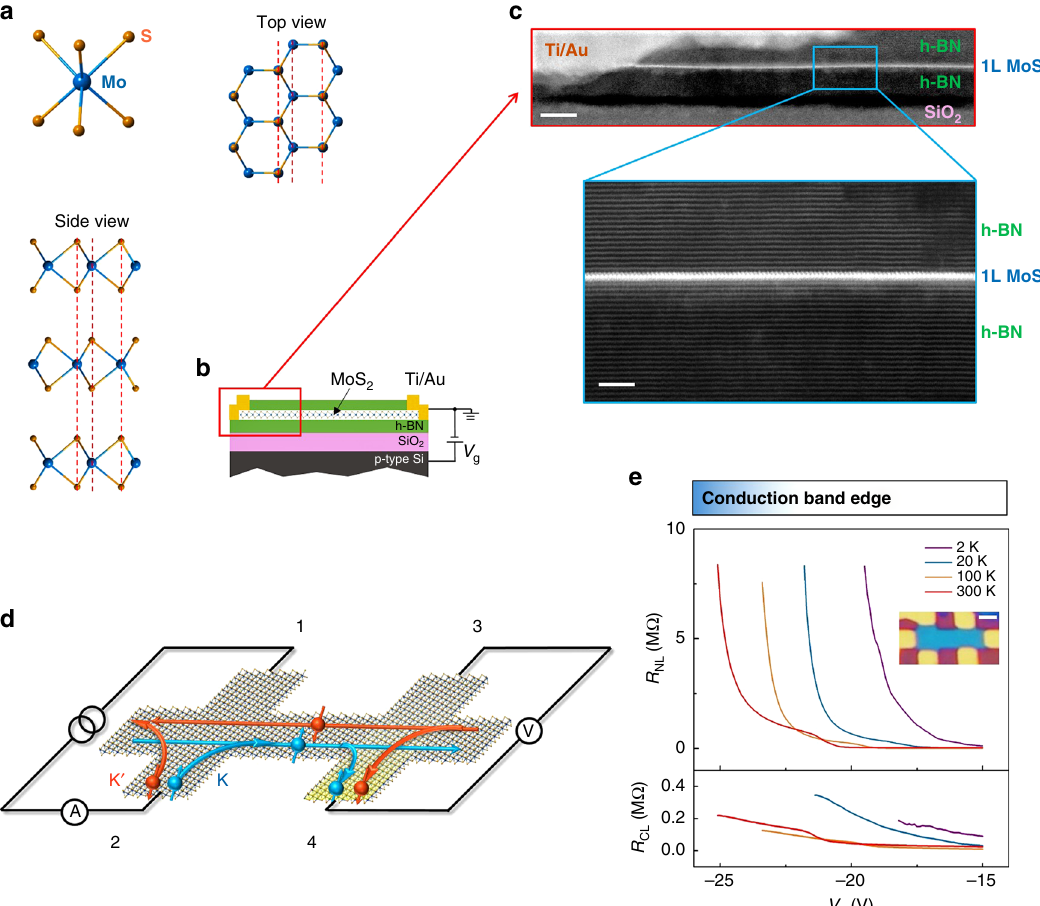
Fig. 1 Valley Hall transport induced nonlocal resistance in monolayer MoS 2 . a Top view and side view of the crystal structure of 2H-MoS 2 ; an odd- (even-) layer is inversion asymmetric (symmetric). b Schematic of the h-BN encapsulated MoS 2 fi eld-effect transistor. c High-resolution bright- fi eld STEM image showing details of the edge-contacted monolayer MoS 2 device structure (scale bar 10 nm). The expanded region shows that the BN-MoS 2 -BN interface is pristine and free of impurities down to the atomic scale (scale bar 3 nm). d Schematic of the nonlocal resistance measurement and the VHE-mediated nonlocal transport. The applied charge current in the left circuit generates a pure valley current in the transverse direction via a VHE. This valley current induces opposite chemical potential gradients for the two valleys over the inter-valley scattering length, which, in turn, generates a voltage drop measured by probes 3 and 4 in the right circuit via an inverse VHE. e Nonlocal resistance R NL (upper panel) and the classical ohmic contribution R CL (lower panel) as functions of gate voltage V g at varied temperatures. Inset: optical image of a typical monolayer MoS 2 device (scale bar 2 μ m). A MoS 2 Hall bar is sandwiched between the top and bottom h-BN fl